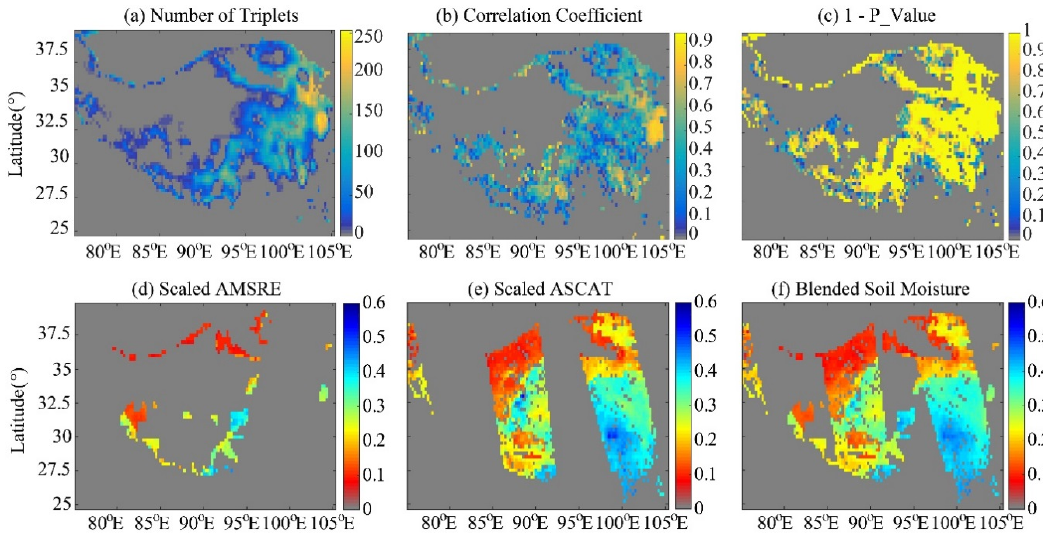
Figure 6. The blending of the scaled AMSRE, ASCAT, and ERA-Interim SM products was implemented with two sub-steps: ( a – c ) sub-step one is to blend the three collocated SM data, as identified by the number of triplets, the minimum correlation coefficient among each other and the p -value. It is to note that ( c ) was shown as (1— p -value) to make it more visible as most of p -value is close to zero; ( d , e ) sub-step two is to blend the rest of data, of which the two satellite SM data collocate individually with the scaled ERA-Interim data, but not collocating with each other; and ( f ) the final blended SM product. ( a – c ) were plotted using the three SM data over the blending period; ( d – f ) are plotted using data on 17 August 2008.